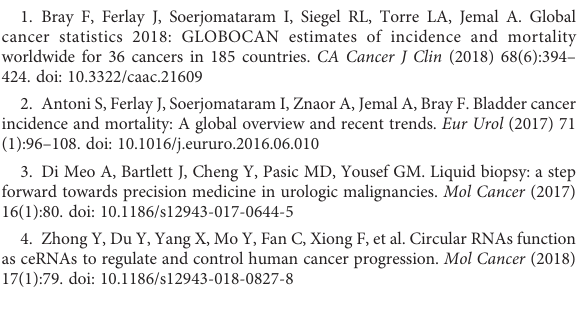
SUPPLEMENTARY TABLE 2 Theassociationanalysisbetweenexpressionofthe fi ltered12miRNAsand clinicopathological factors of patients with BCa. Exp., Expression level; Lymphatic met., Lymphatic metastasis. * P<0.05; ** P<0.01; *** P<0.001; Fisher ’ s exact test.